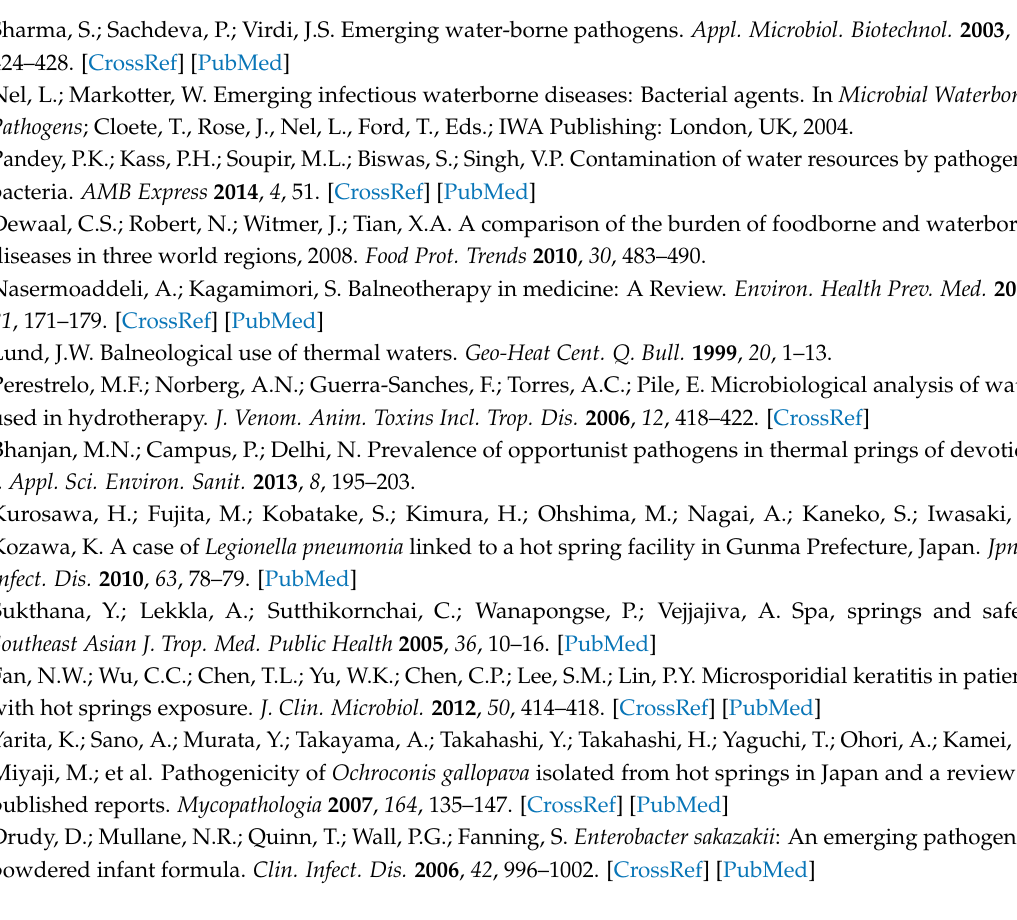
Figure S1: Bacteria isolated from various hot springs worldwide, Table S1: Waterborne opportunistic bacterial pathogens, Table S2: Closest match of 16S rDNA gene sequence from hot-spring isolates with GenBank and EzTaxon-e with percentage similarity and associated accession numbers, Table S3: List of the accession numbers of all the strains from GenBank used in phylogenetic analysis, Table S4: List of emerging opportunistic pathogens that have been isolated from hot-spring water, List S1: Raw sequence data to be submitted to GenBank. Acknowledgments: We thank the African Centre for DNA Barcoding, University of Johannesburg, South Africa for their assistance in DNA sequencing, and the University of Johannesburg for student bursary